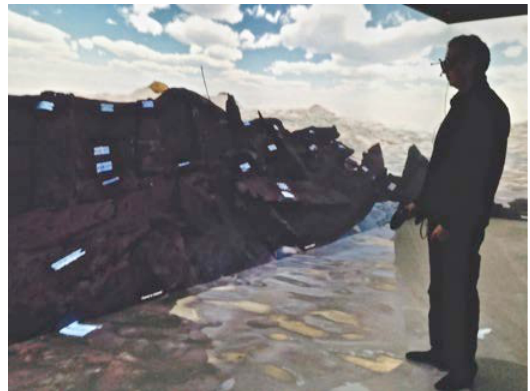
Figure 14. Immersive 1:1 view of the textured mesh in Immersia